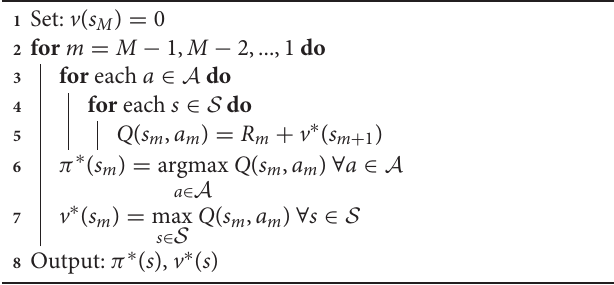
Algorithm 1: Value iteration for solving Finite-Horizon MDP.